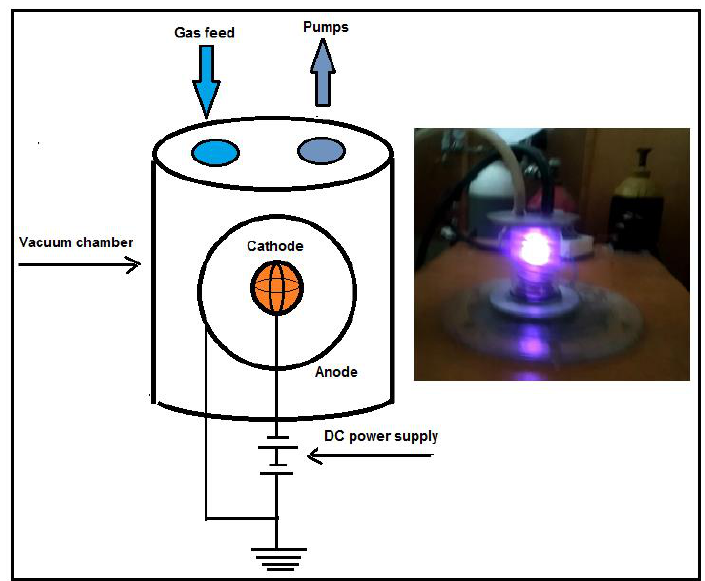
Figure 1. Schematic diagram and photo of experimental setup.